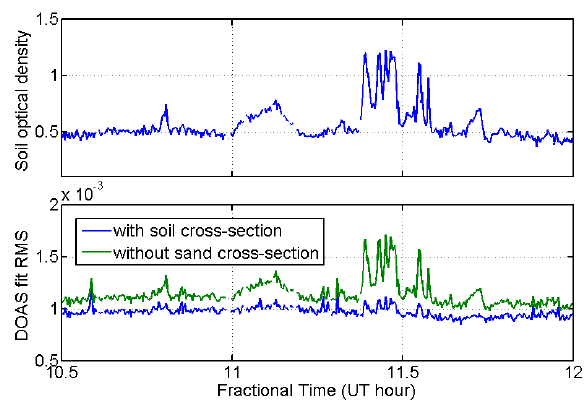
Fig. 15. Time series of the soil signature signal (upper panel) and root mean square of the DOAS fit (lower panel), with (blue curve) and without (green curve) the soil signature in the fit. The spectra were recorded above Saudi Arabia when the pilots reported their crossing of a sand